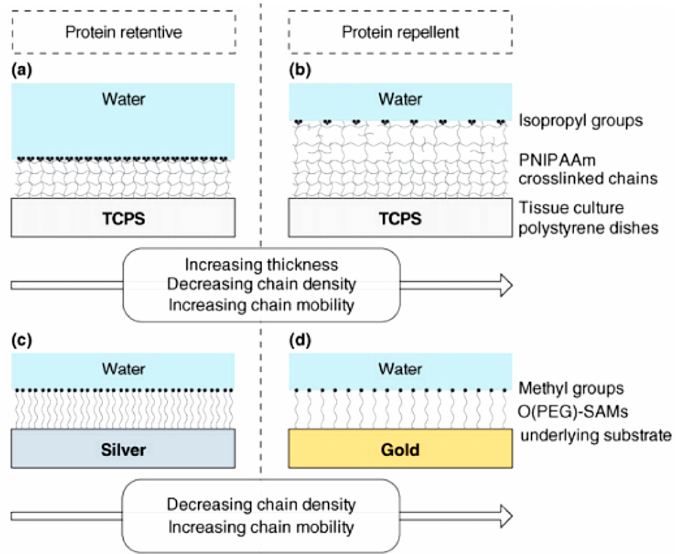
Figure 9. Hydrodynamic diameter variation of crosslinked PAM/PNIPAM due to temperature. ( a ) Schematic plot of e-beam-grafted insoluble PNIPAM surface; ( b ) PNIPAM chain density decreases with the increase of graft thickness; ( c ) Schematic plot of methoxy-terminated oligo self-assembled monolayers on silver; ( d ) Less compacted self-assembled monolayers forming on gold. Reprinted with permission from [120].